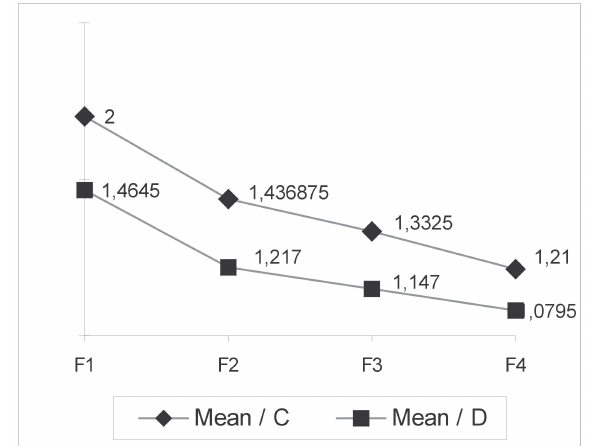
FIGURE 2- TUKEY test (HSD) for determination of the general means and pattern of difference between the groups, methods and stages